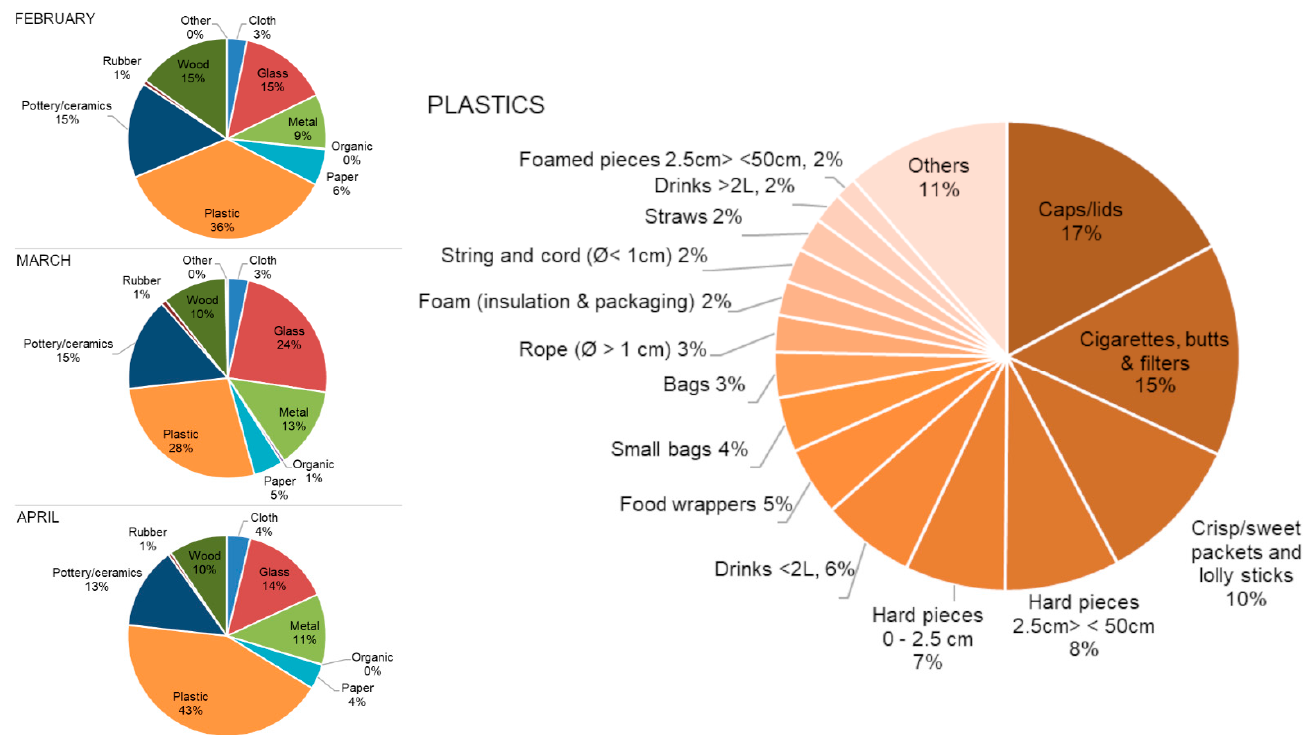
Figure 6. Beach litter composition during sampling period by material type (sector diagrams on the left). Most represent plastic litter categories (sector diagram on the right). The percentage of a specific litter category is calculated as the quantity of all items belonging to such category with respect to the total amount of litter items counted.